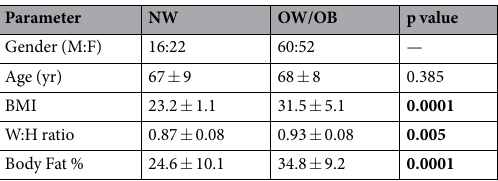
Table 2. Patient characteristics of normal-weight (NW, n = 38) and over-weight/obese (OW/OB, n = 112) OA patient cohorts. W:H ratio = waist circumference:hip circumference. Values represent the mean ±